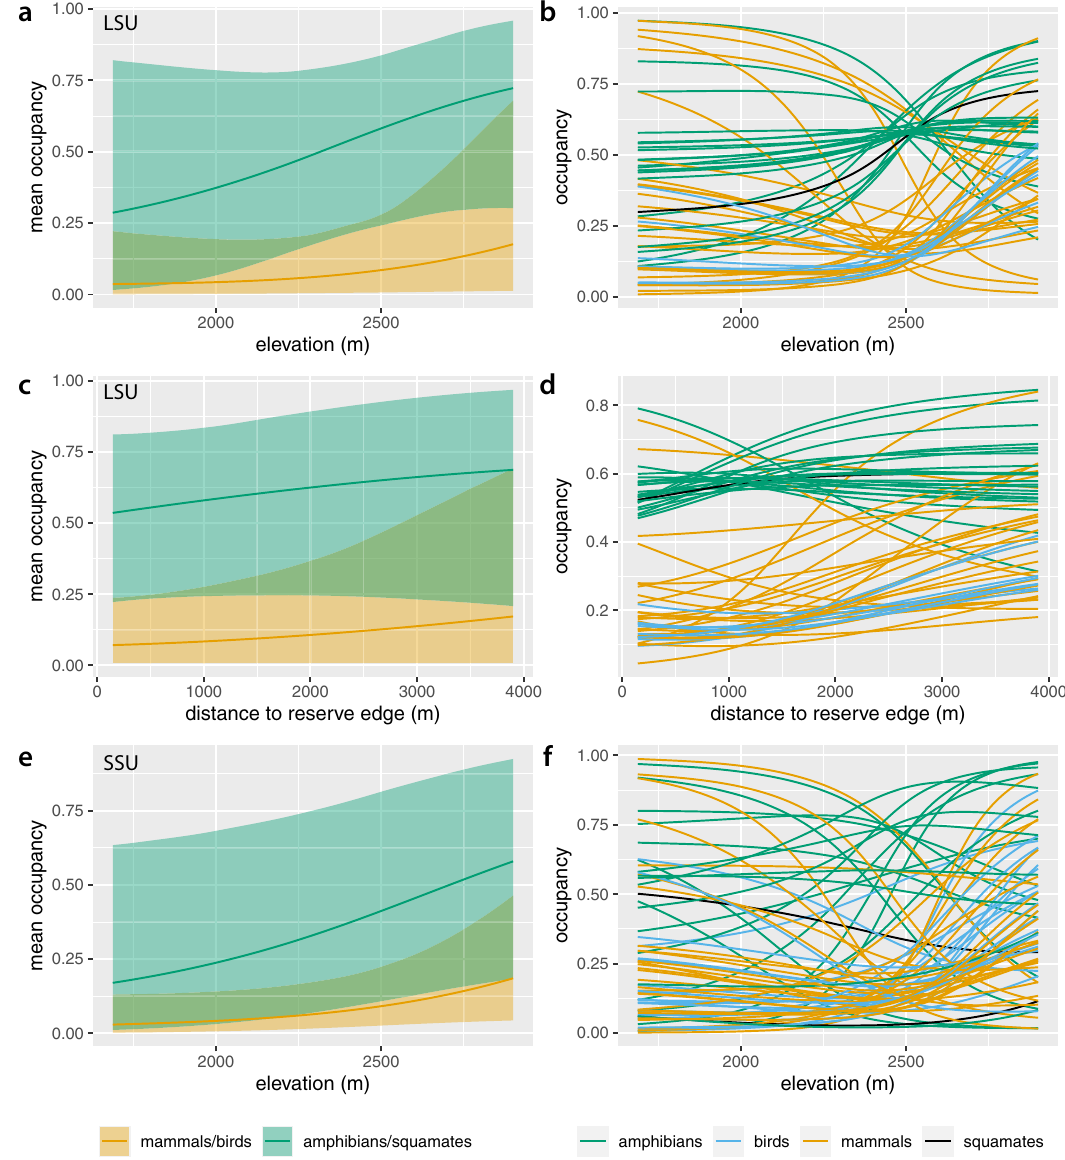
Fig. 4 Occupancy estimates versus environmental covariates. a Community mean occupancy estimates and b occupancy estimates for each species as a function of elevation in the LSU dataset, holding distance to reserve edge fi xed at its mean value. c Community mean occupancy estimates and d occupancy estimates for each species as a function of distance to reserve edge in the LSU dataset, holding elevation fi xed at its mean value. e Community mean occupancy estimates and f occupancy estimates for each species as a function of elevation in the SSU dataset, holding distance to reserve edge fi xed at its mean value. Lines in all panels show posterior means. Shaded areas in panels a , c and e show 95% Bayesian con fi dence intervals from models based on n = 893 replicate